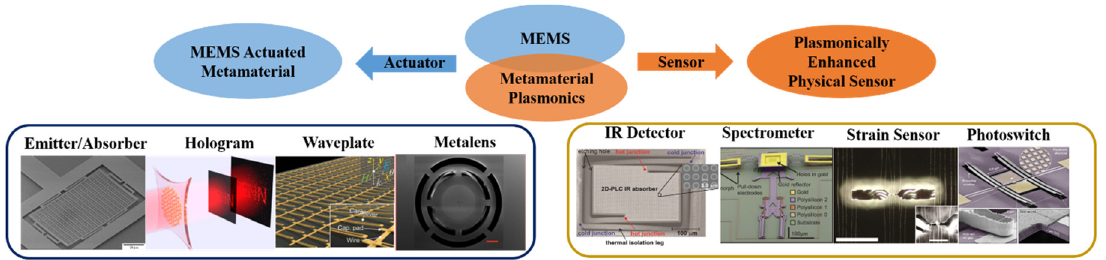
Figure 1: A block-diagram illustration for the integration of microelectromechanical system (MEMS) and metamaterials: MEMS actuated metamaterialsandplasmonicallyenhancedphysicalsensors.Milestonesfortheformerincludetunableemitter/absorber[40],hologram[41], tunable waveplate [41], and metalens [42] while milestones for the latter include IR detector [43], spectrometer [44], strain sensor [45] and photoswitch